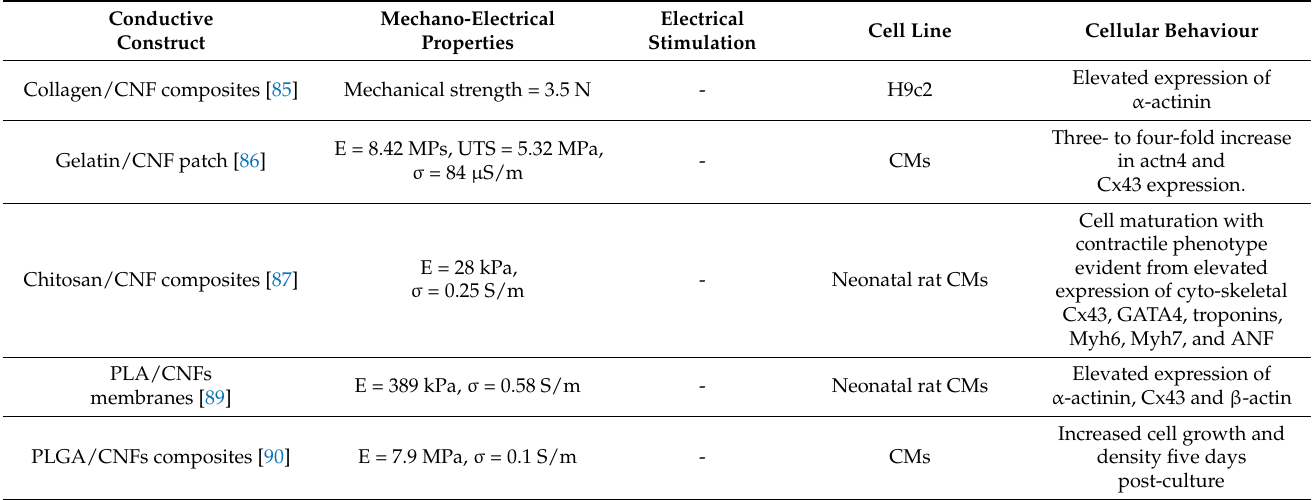
Table 4. Carbon nanofibers-based conductive constructs for cardiac tissue engineering